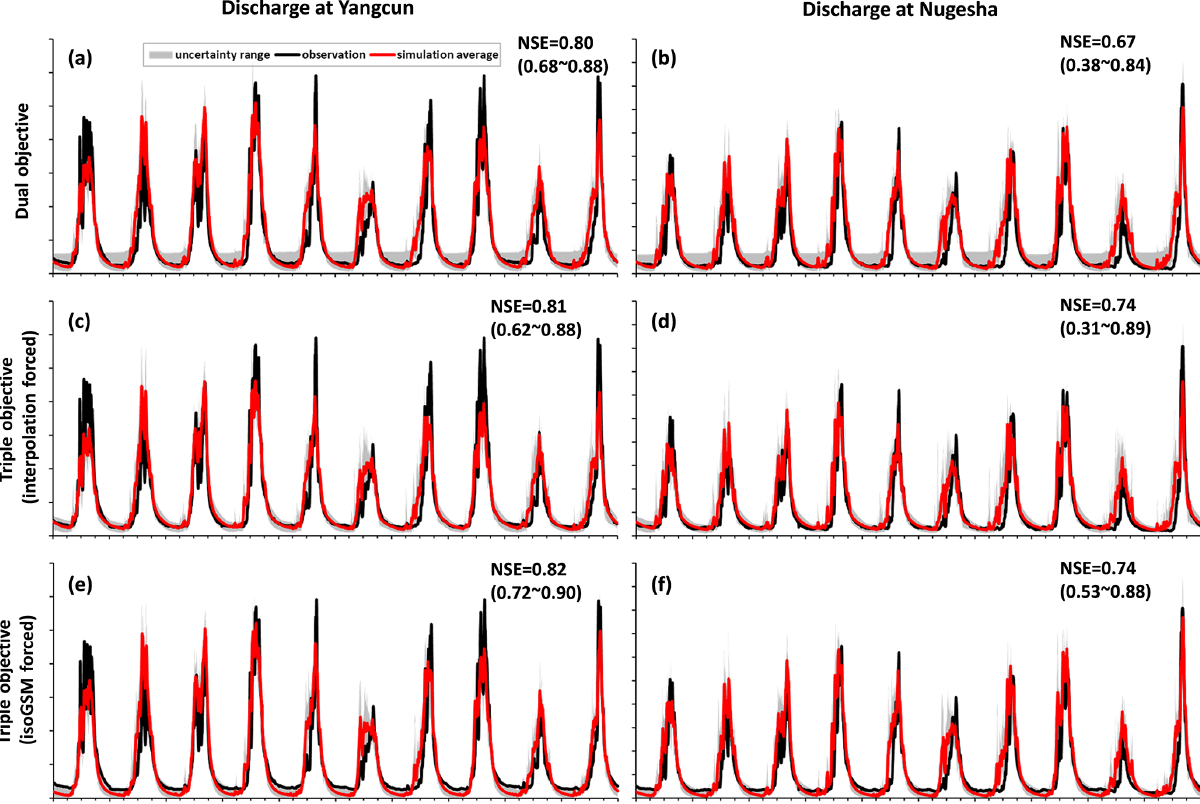
Figure 8. Uncertainty ranges of discharge simulations at Yangcun and Nugesha stations produced by the behavioral parameter sets of the dual-objective (a, b) , interpolation-forced triple-objective (c, d) and isoGSM-forced triple-objective (e, f) calibration